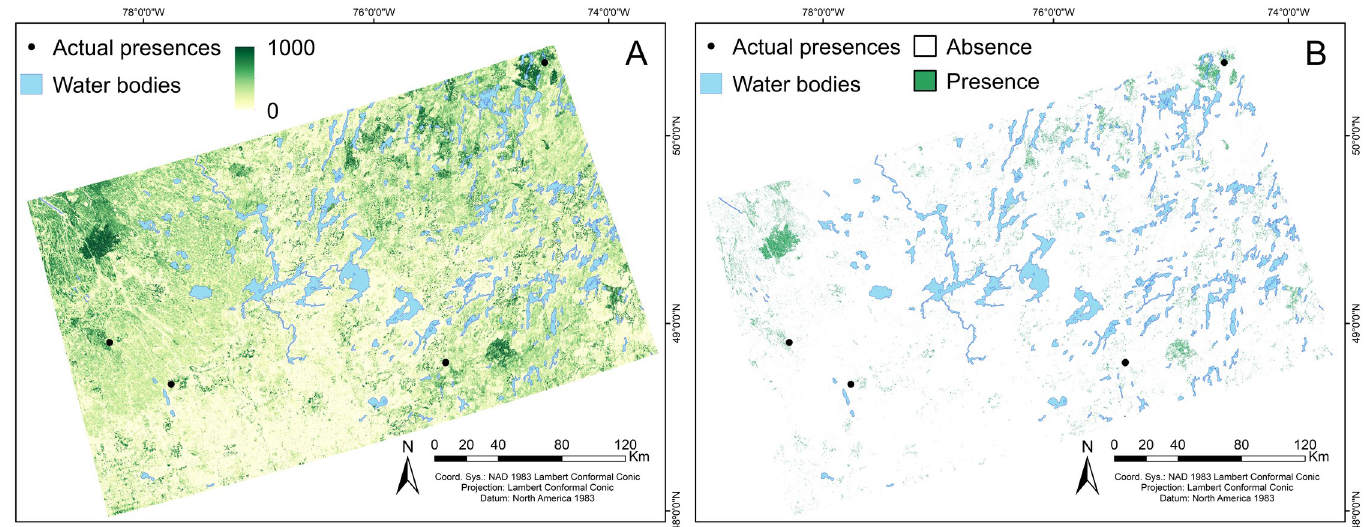
Fig 2. Example of (A) continuous and (B) binary predictive mapping of the moss Trematodon ambiguus (Hedw.) Hornsch. for the study area at 30 m spatial resolution.